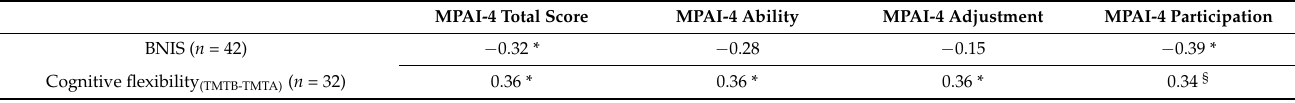
Table 3. Correlation between MPAI and neuropsychological screening